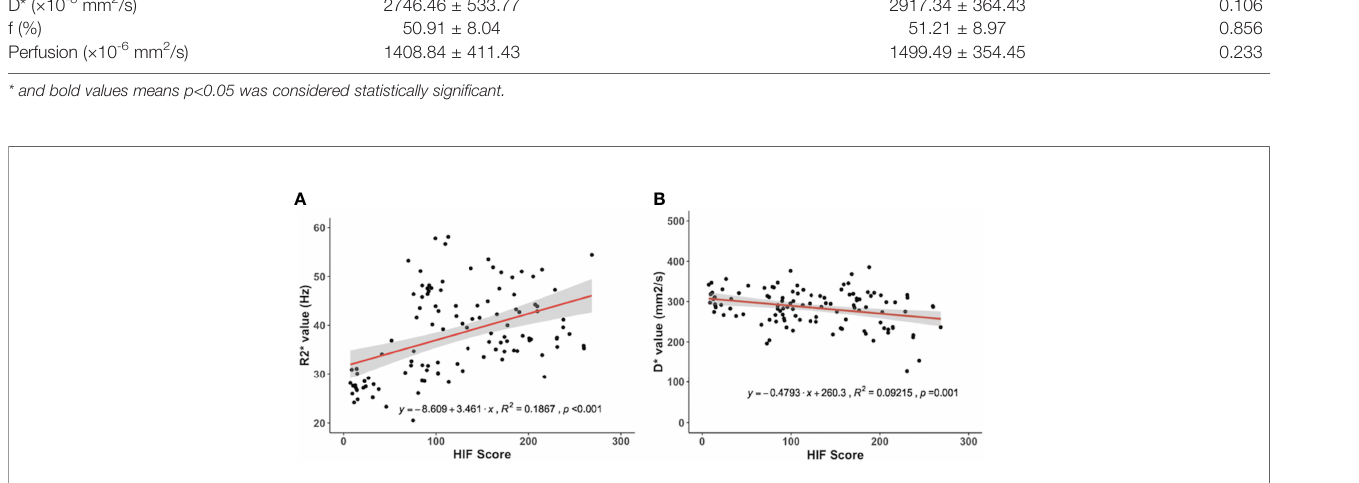
FIGURE 4 | Correlations for the hypoxia ‐ inducible factor 1 a (HIF ‐ 1 a ) with the pseudodiffusion coef fi cient (D*) and the apparent transverse relaxation rate (R2*). (A) HIF ‐ 1 a correlated positively with the R2* value (r = 0.43, p < 0.001). (B) HIF ‐ 1 a correlated negatively with D* (r = -0.30, p = 0.001).